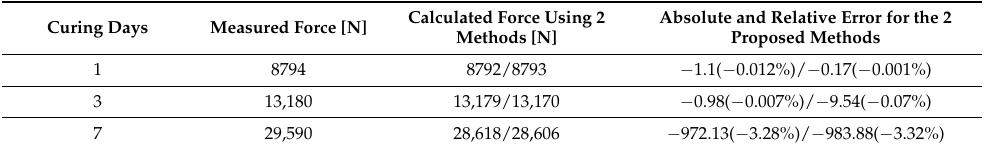
Table 5. Measured and calculated forces for the three simulated cases 1 day, 3 days and 7 days. Curing